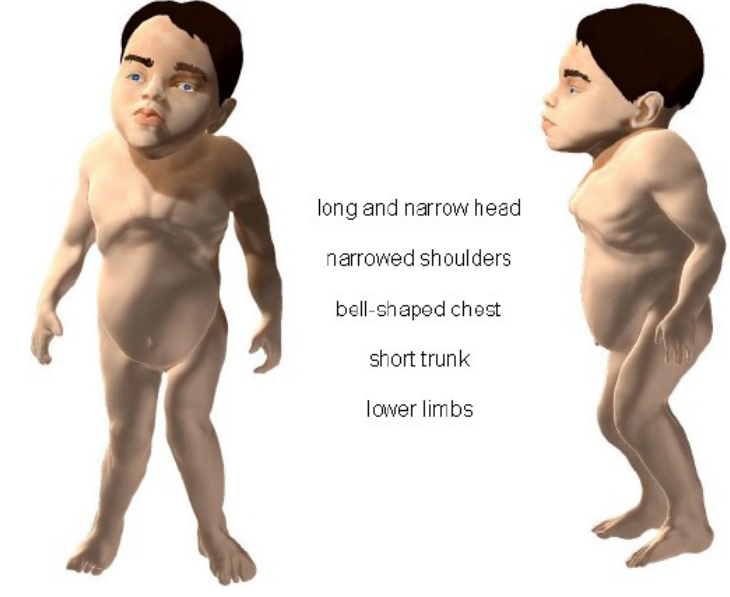
Figure 5. Computer Figure 5. Computer profile. Figure 5. Computer profile.